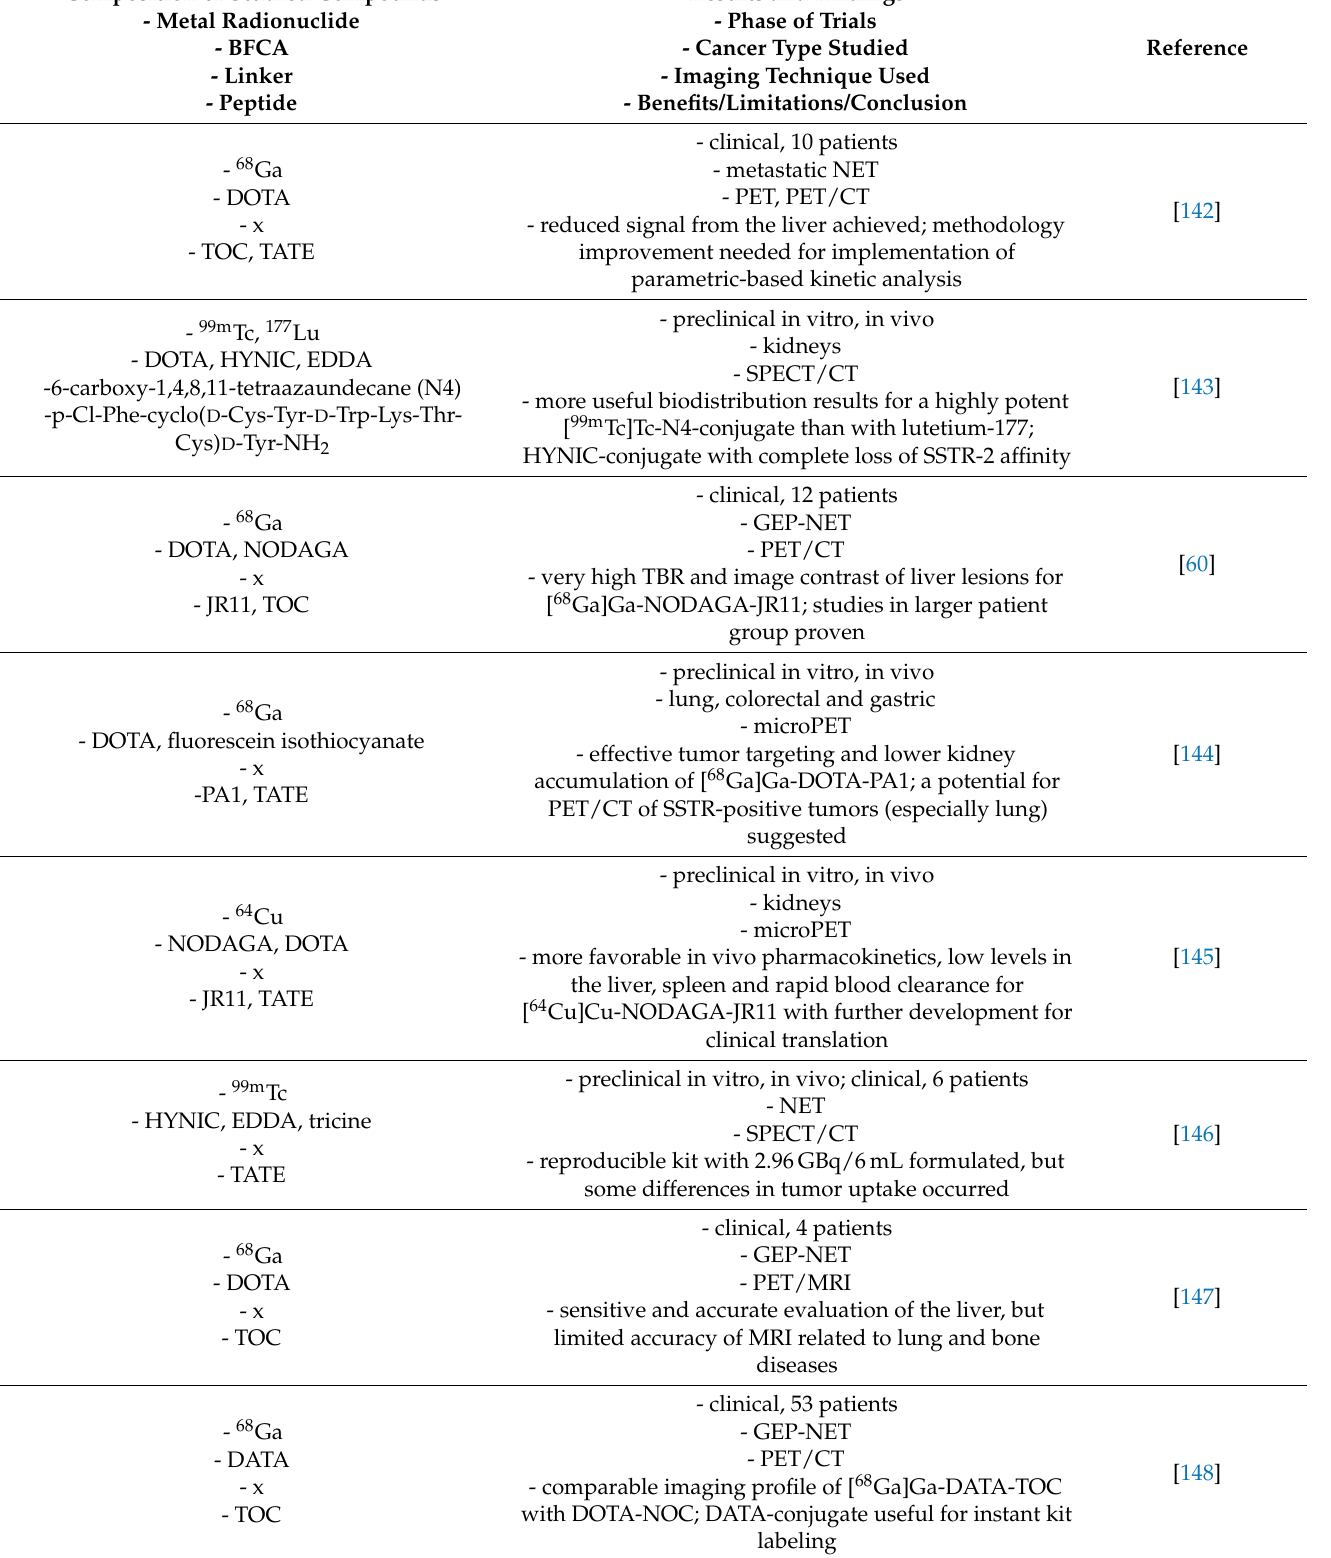
Table 7. Summary of radiolabeled somatostatin analogues for SSTR-positive tumor imaging over past 3 years. Composition of Studied